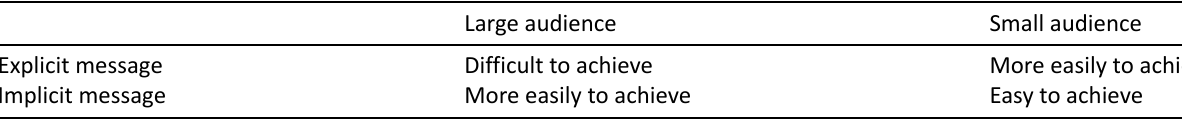
Table 2. Artworks’ to contribute to an inclusive public